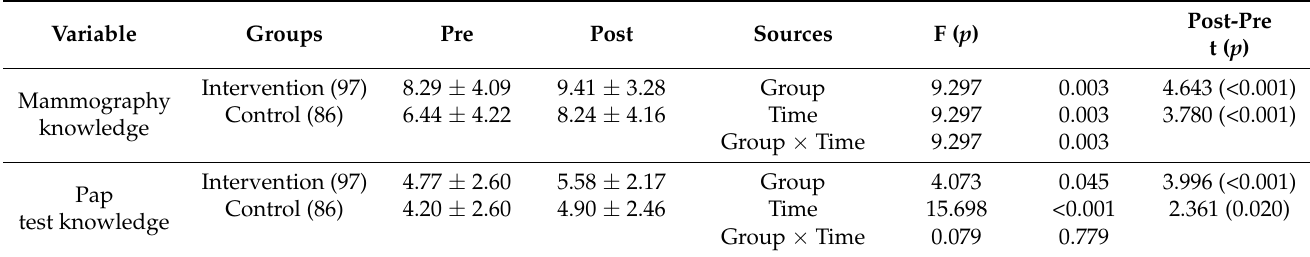
Table 2. Comparison of mammography knowledge and Pap test knowledge (n = 183).